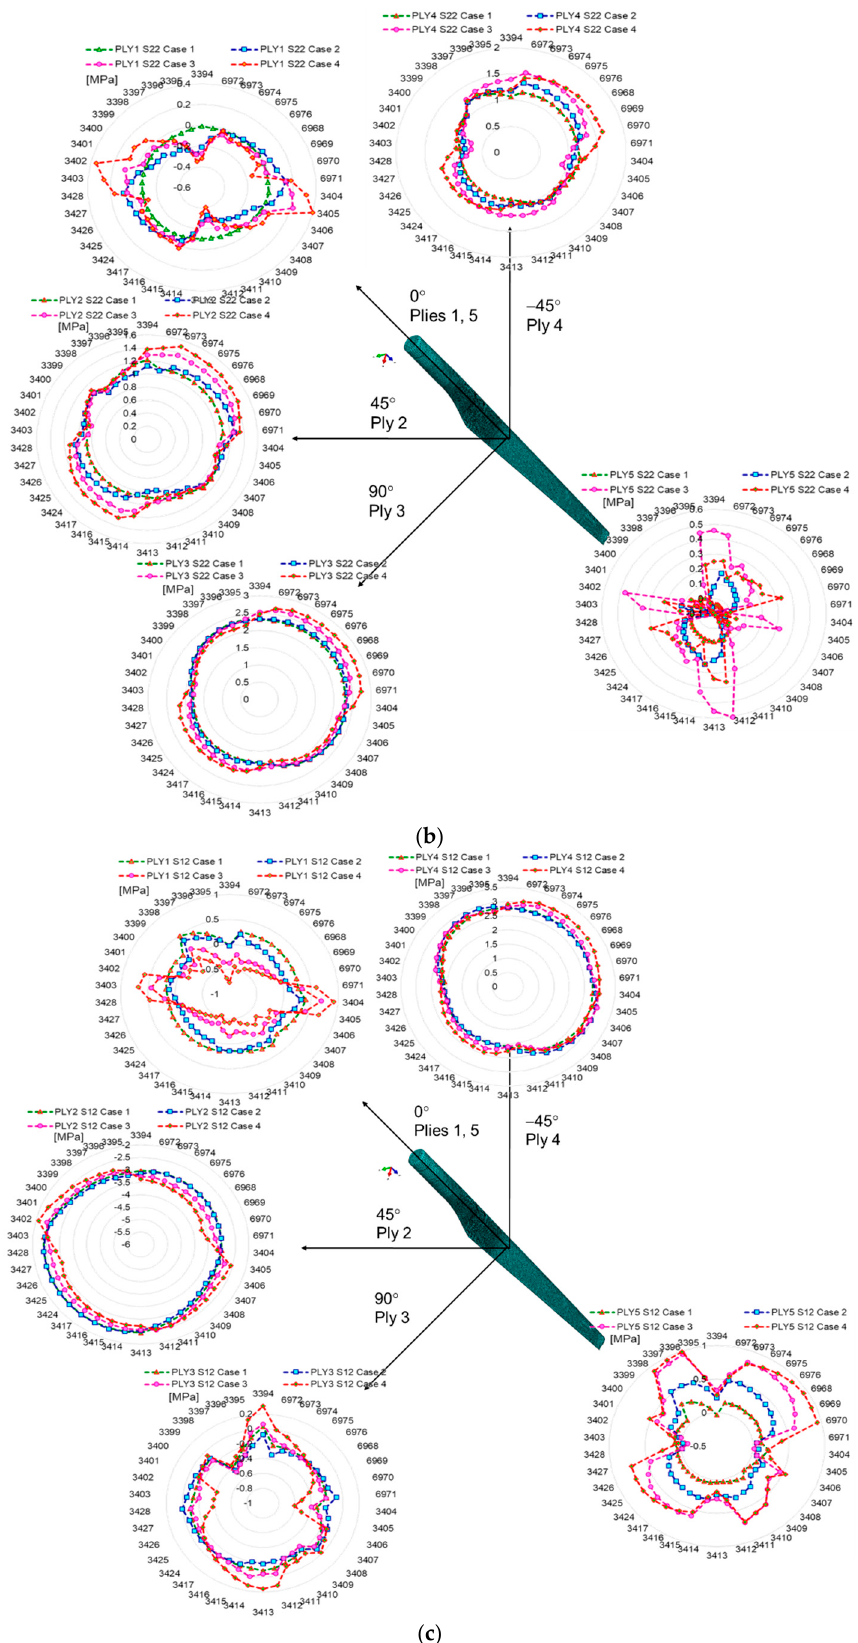
Figure 6. Variation of stresses in relation to the composite layer orientation, extracted from area